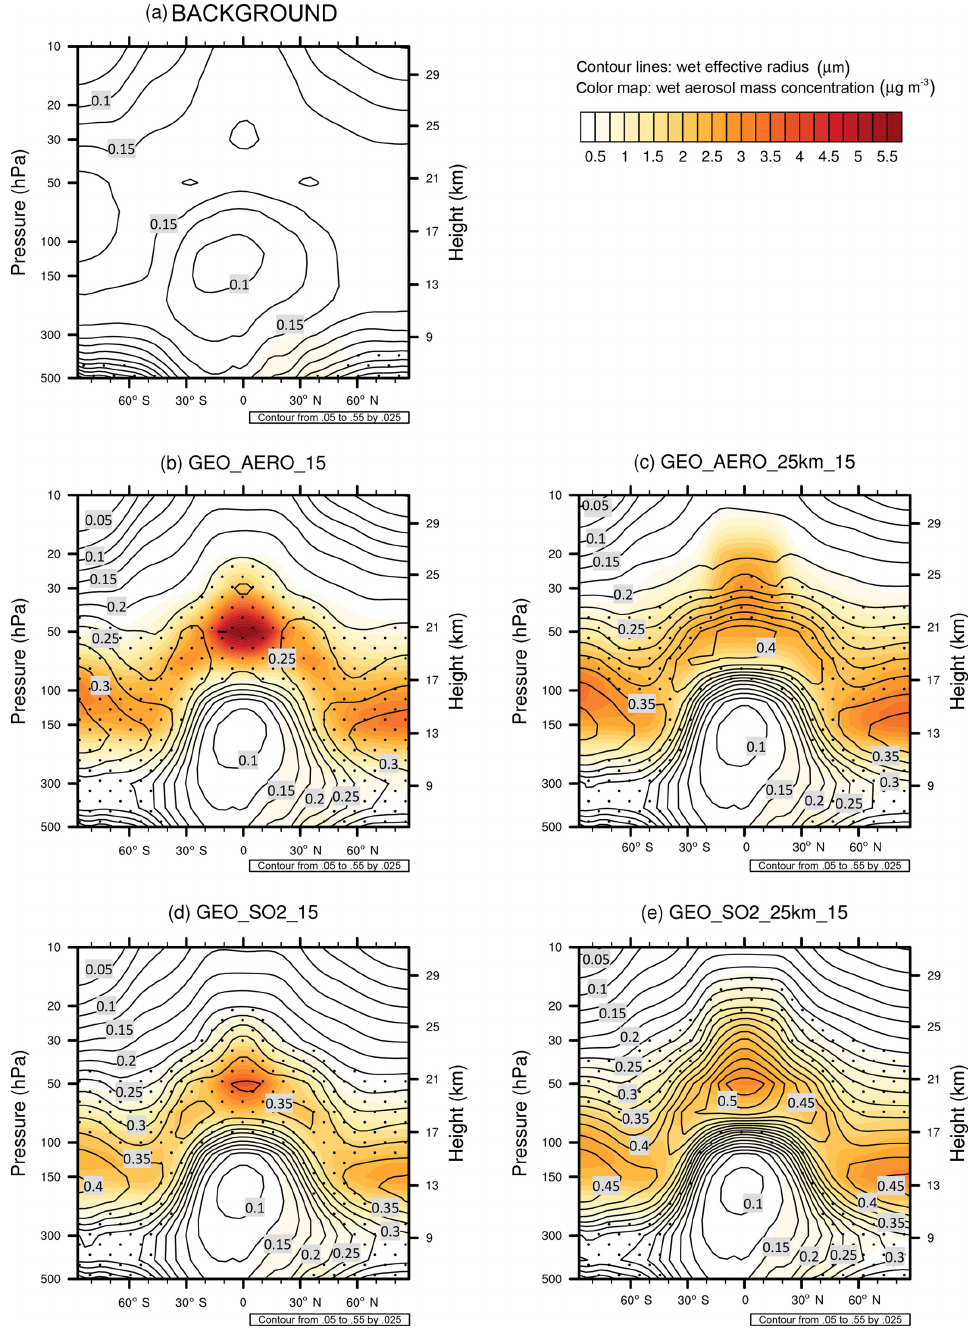
Figure 3. Contour lines show the wet effective radius (i.e., the ratio between the third moment and the second moment of the aerosol size distribution) inµm. The stippled area depicts the size range with effective radii between 0.24 and 0.36µm. It is the range in which the backscattering efficiency is larger than 90% of its peak value at 0.3µm following Dykema et al. (2016). Color maps show the wet aerosol mass distribution in µgm − 3 both zonally averaged over 10 years for background conditions (a) , GEO_AERO_15 (b) , GEO_AERO_25km_15 (c) , GEO_SO2_15 (d) and GEO_SO2_25km_15 (e)